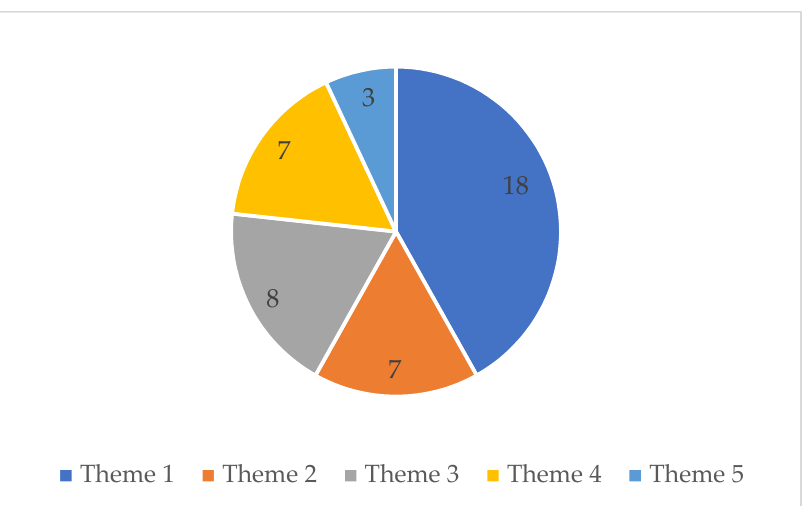
Figure 5. Distribution of articles based on research themes ( n = 43): Theme 1 (the physicality of urban green space); Theme 2 (the experience of urban green space); Theme 3 (the valuation of urban green space); Theme 4 (the management of urban green space); Theme 5 (the governance of urban green space).